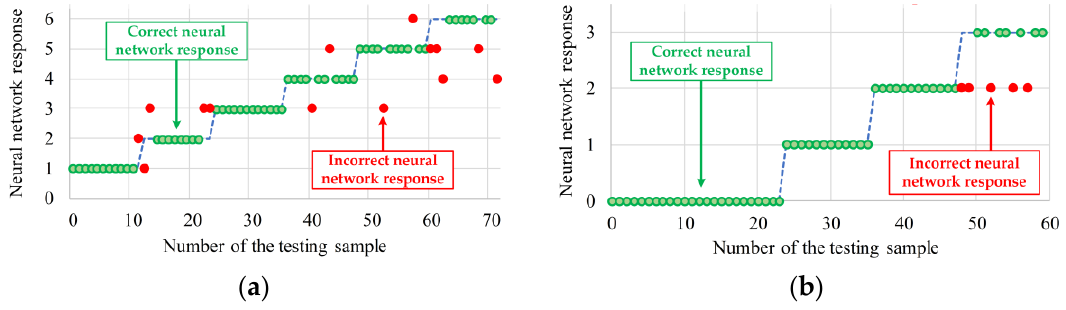
Figure 11. SOM–RHN network response: ( a ) shorted turns of stator windings; ( b ) rotor broken bars.